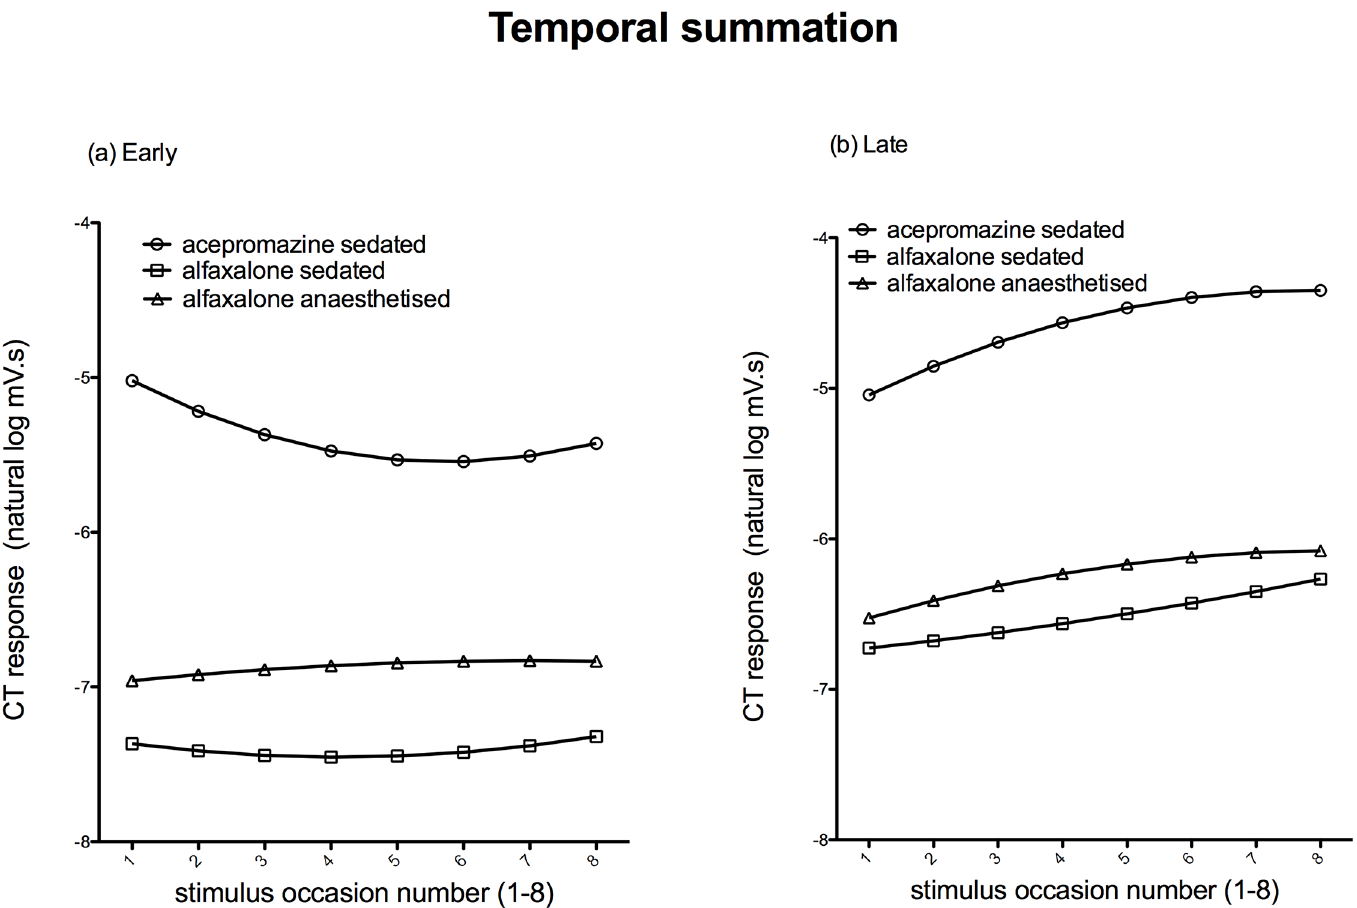
Fig 8. Mean EMG responses to temporal summation; early 0-100ms (a) and late 100-500ms (b). Responses of the acepromazine sedated group are represented by (cid:3) , alfaxalone sedated by □ , and alfaxalone anaesthetised by 4 .